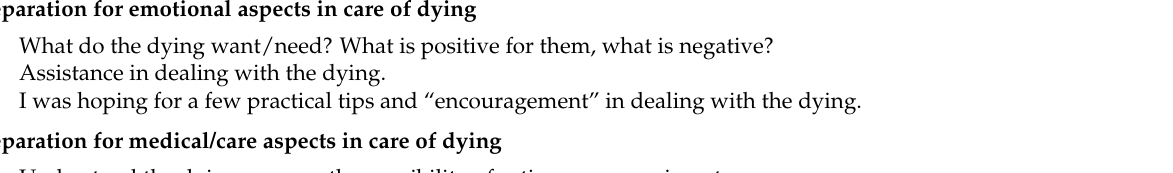
Table A1. Pre-Survey examples of answers to the question: “What were your goals and concerns before joining the course?” These can be professional or private concerns.